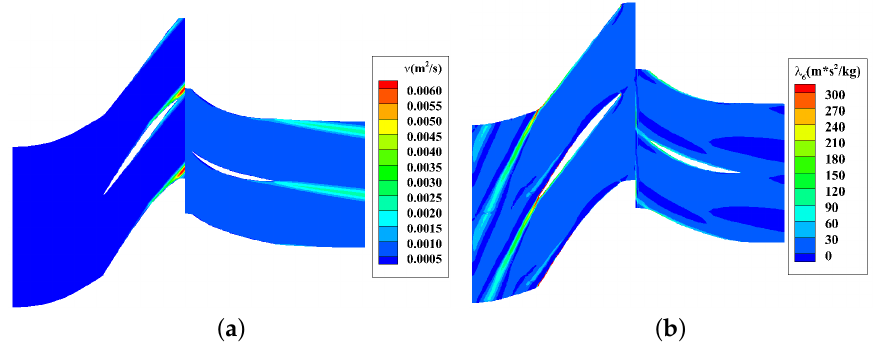
Figure 12. Flow and adjoint fields at 50% span of the NASA Stage 35. ( a ) Turbulence quantity. ( b ) Adjoint quantity corresponding to the turbulence model